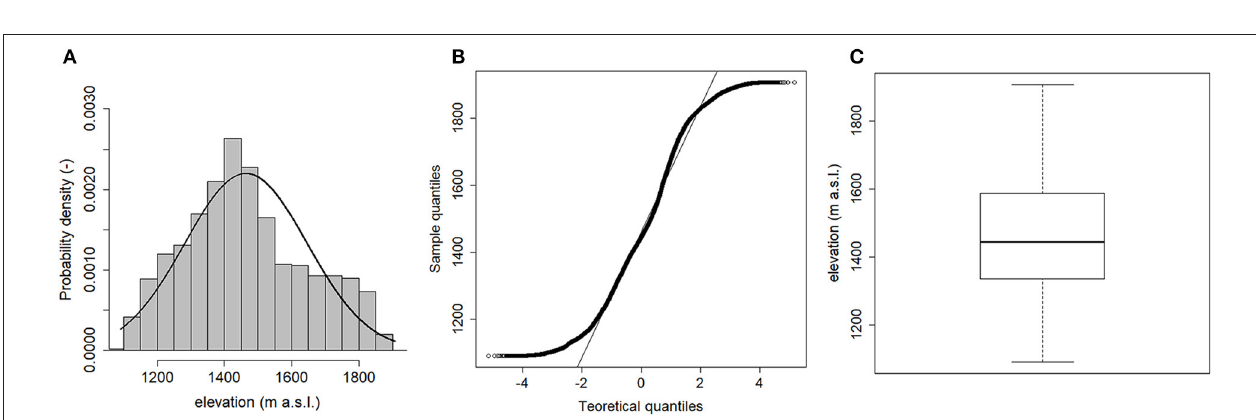
FIGURE 3 | Histogram with superimposed the normal distribution (A) , normal Q-Q plot (B) , and box-plot (C) of the LiDAR ground points